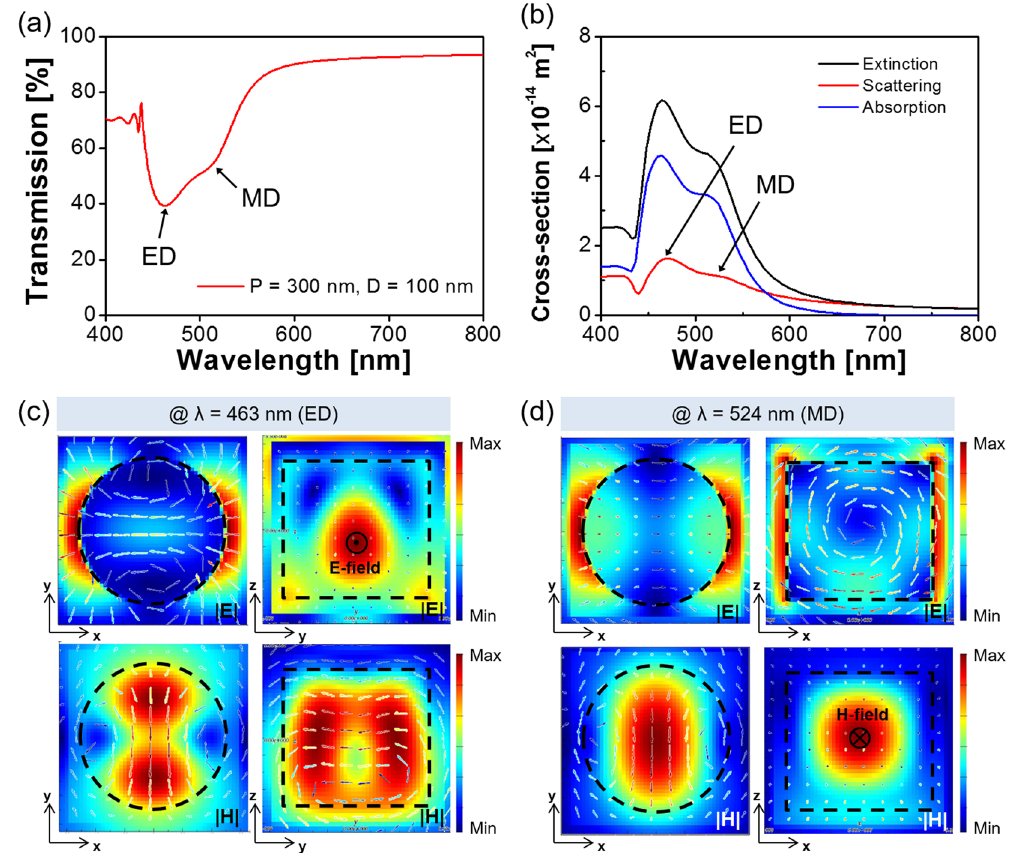
Figure 6. ( a ) Calculated transmission spectra for the metasurface with P = 300 nm and D = 100 nm, providing double resonances at λ = 463 nm and 524 nm. ( b ) Calculated extinction, scattering, and absorption cross- sections for the a-Si:H nanodisk. Field profiles for ( c ) the ED resonance at λ = 463 nm and ( d ) the MD resonance at λ = 524